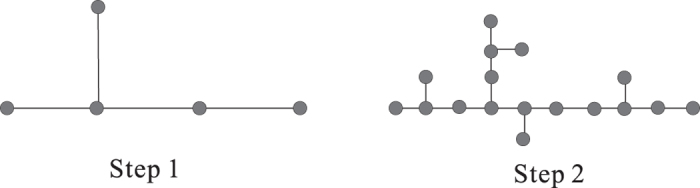
G1, G2 of growing trees w.r.t. rule 2.